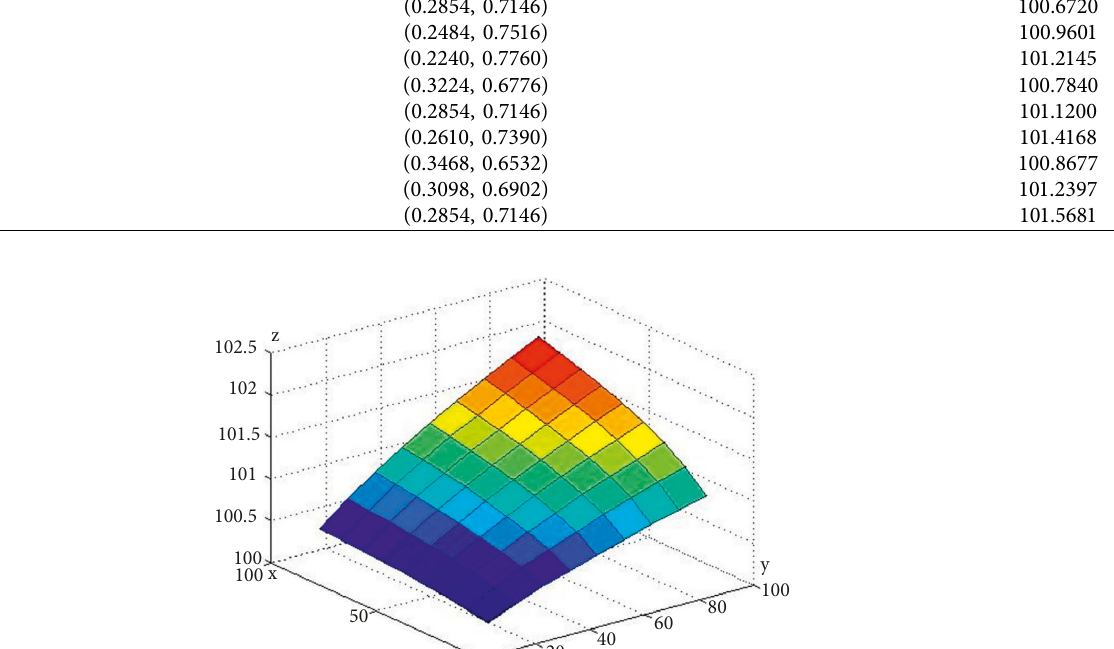
Figure 4: Changes of the expected loss with L denotes the losses caused by invasion to the application software ( L